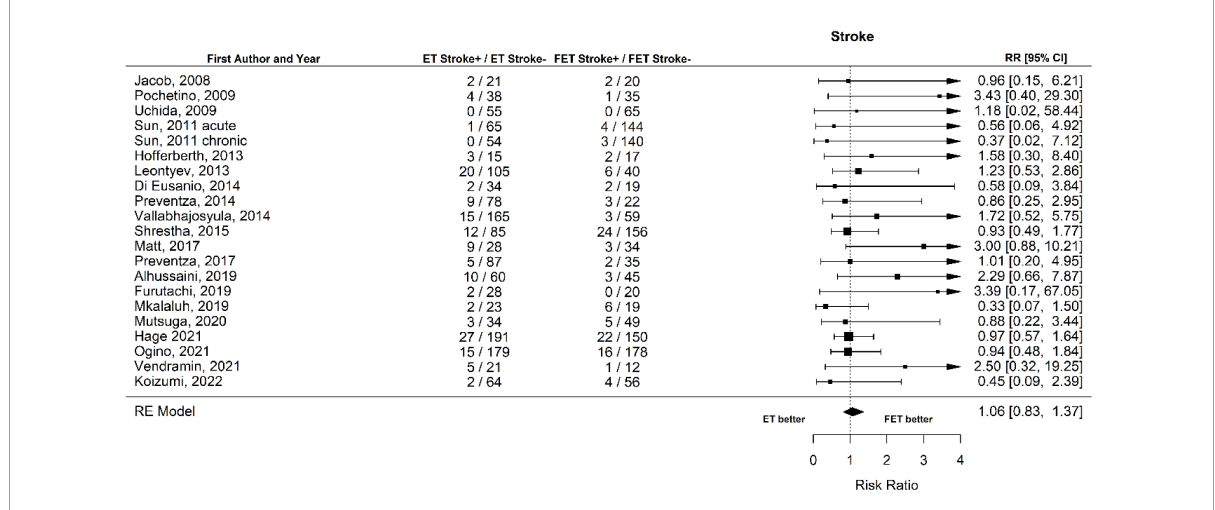
FIGURE6 Relative risk of stroke in patients undergoing aortic interventions with conventional elephant trunk (ET) vs. frozen elephant trunk (FET). Forest plot p =